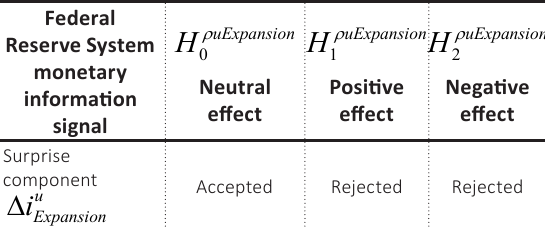
Table 11. Testing results for